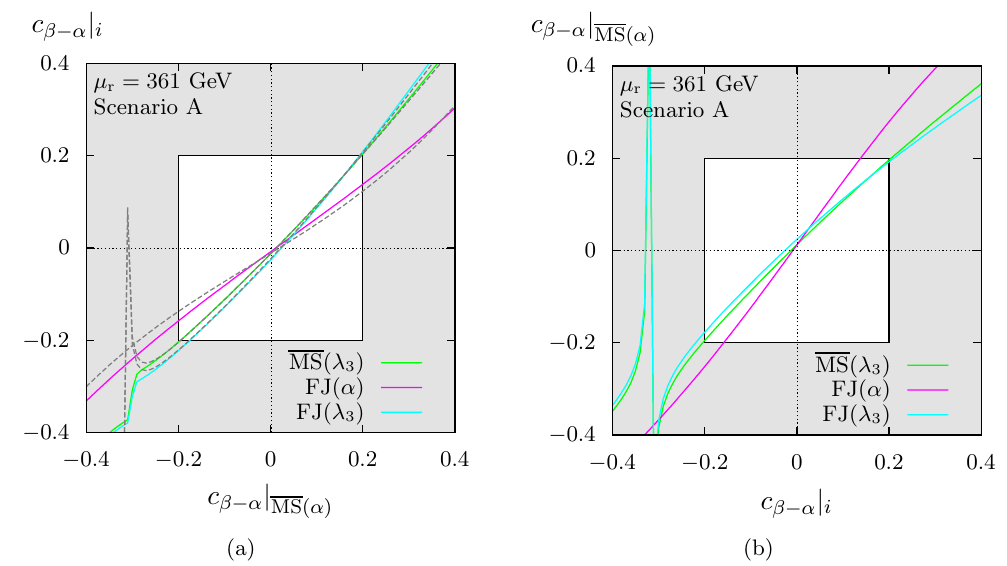
Figure 4 . (a) Conversion of the value of c (cid:12) (cid:0) (cid:11) from MS( (cid:11) ) to the MS( (cid:21) and FJ( (cid:21) 3 ) schemes (turquoise) for scenario A. Panel (b) shows the conversion to the MS( (cid:11) ) scheme using the same colour coding. The solid lines are obtained by solving the implicit equations (4.61) numerically, the dashed lines correspond to the linearized approximation. The phenomenologically relevant region is highlighted in the